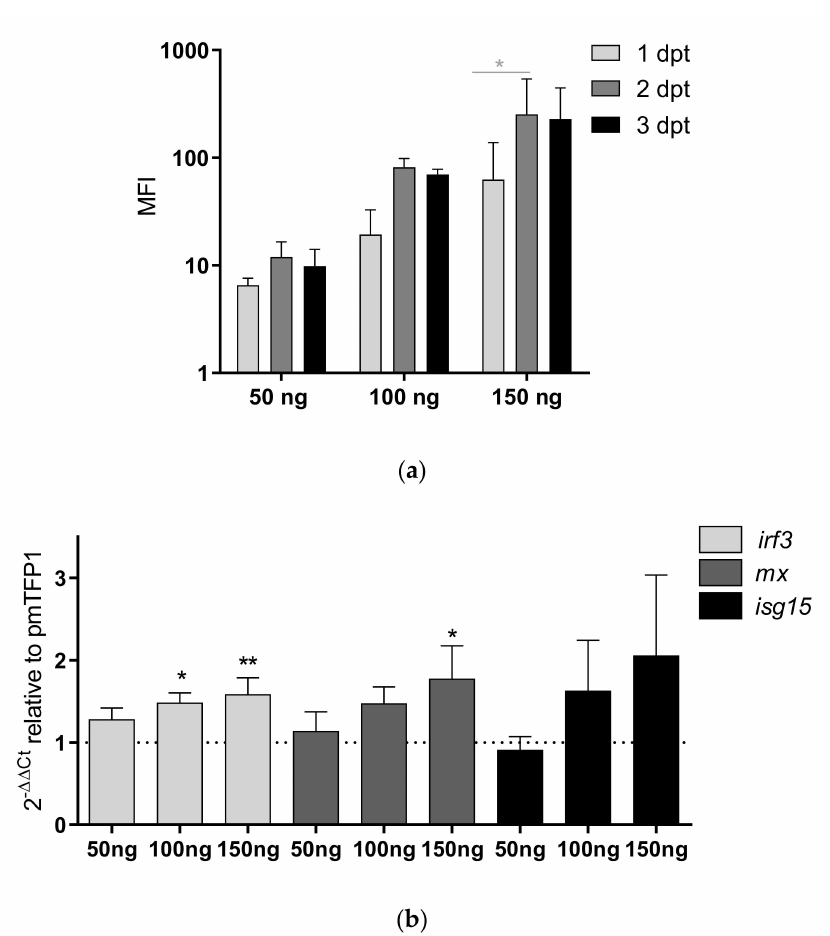
Figure 5. Time course of transfected EPC cells with pmTFP1-NKEF. EPC cells were electroporated with the plasmid pmTFP1-NKEF at different concentrations (50 ng, 100 ng, and 150 ng). NKEF expression was monitored at various time points. ( a ) Evaluation of NKEF protein levels using flow cytometry via the fluorescence emitted by the NKEF-bound TFP1 protein. Data represent mean fluorescent intensity (MFI)(mean ± SD of two experiments). h indicates hours. A two-way ANOVA and Tukey’s multiple comparisons test were performed for statistical analysis, between plasmid concentrations and times post-transfection (gray lines and asterisks). * indicates a p -value of <0.05. ( b ) Analysis of the IFN1-related genes ( irf3, mx, isg15 ) modulation in EPC cells transfected with the plasmid pmTFP1-NKEF at 48 h. Gene expression was evaluated by RT-qPCR, normalized to pmTFP1 transfected cells (control, dashed line). C arp-ef1 α was used as endogenous control gene. Data represent the mean ± SD (n = 2 experiments). Bars represent the expression of irf3 (light grey), mx (dark grey) and isg15 (black). The Kruskal–Wallis test and Dunn’s multiple comparison post hoc tests were performed and compared with the control. * and ** indicates a p -value of <0.05 and 0.01